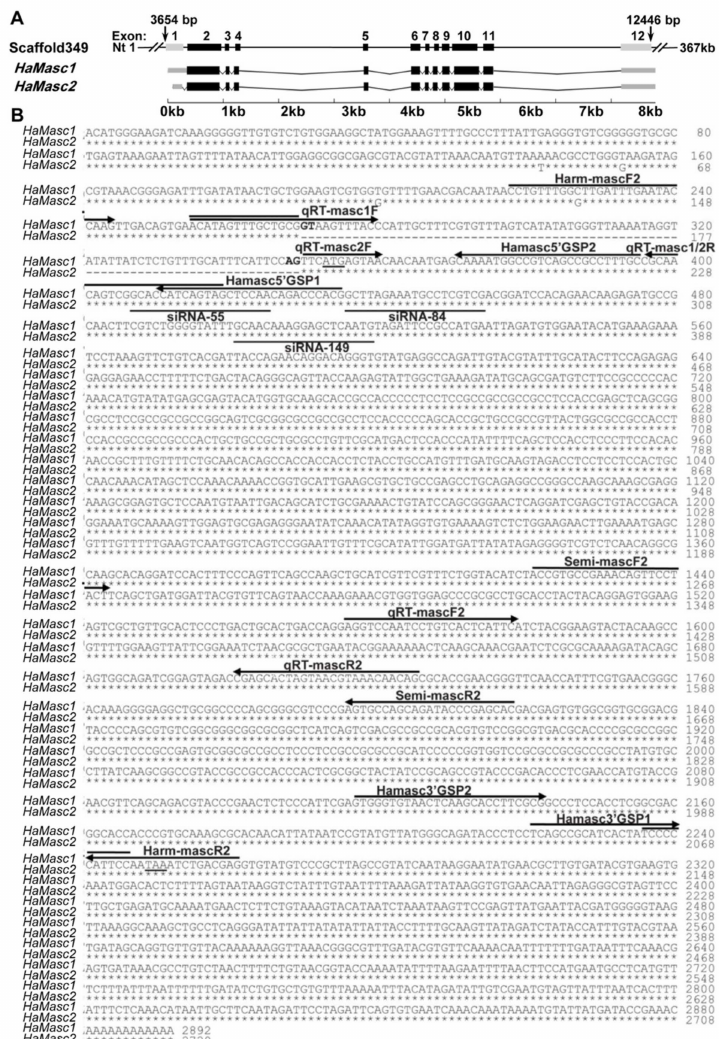
Figure 1. Identification and characterization of HaMasc. ( A ) Genomic structure of HaMasc gene. Black boxes represent the ten exons for the common ORF of the two HaMasc transcripts. Gray boxes depict the exons for the 5 (cid:48) and 3 (cid:48) UTR of the HaMasc transcripts. The spaces between boxes indicate introns. The size of the putative exons and introns is drawn to scale. ( B ) cDNA nucleotide sequence of HaMasc transcripts. The two transcripts of HaMasc , called HaMasc1 and HaMasc2 , are aligned with asterisks (*) and dashes (-) depicting the conserved nucleotides and indels (insertions/deletions) between the two transcripts, respectively. The start (ATG) and stop (TGA) codons are underlined. The target regions of the three siRNA are indicated by lines and the corresponding siRNA names. The annealing directions and positions of the primers used for the 5 (cid:48) RACE, 3 (cid:48) RACE, and full-length cDNA cloning of HaMasc , as well as for RT-PCR and RT-qPCR analyses of HaMasc , are depicted with arrowed lines and the corresponding primer names. When two primers or siRNAs partially anneal to or target the same positions, they have an overlapping